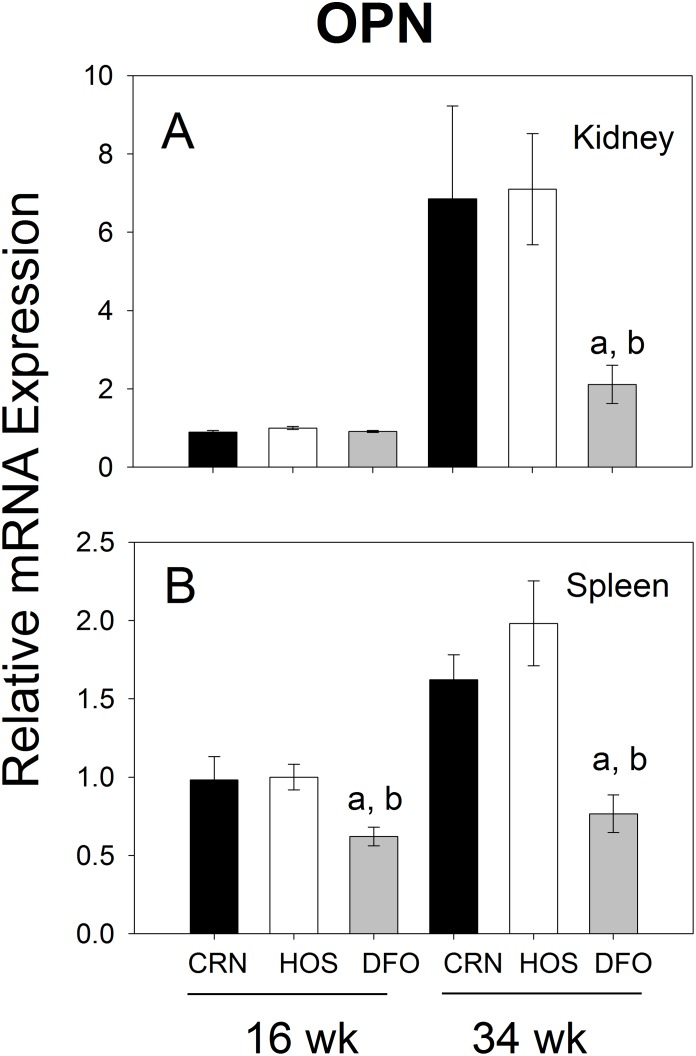
Differential effects of n-3, n-6 and n-9 PUFA consumption on OPN mRNA expression.Experiment conducted as described in Fig. 7 legend except that OPN mRNAs were measured by quantitative RT-PCR.